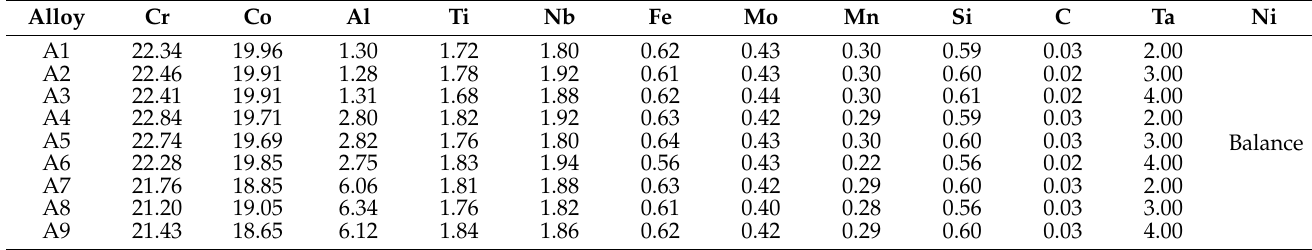
Table 2. A1–A9 superalloy chemical composition,